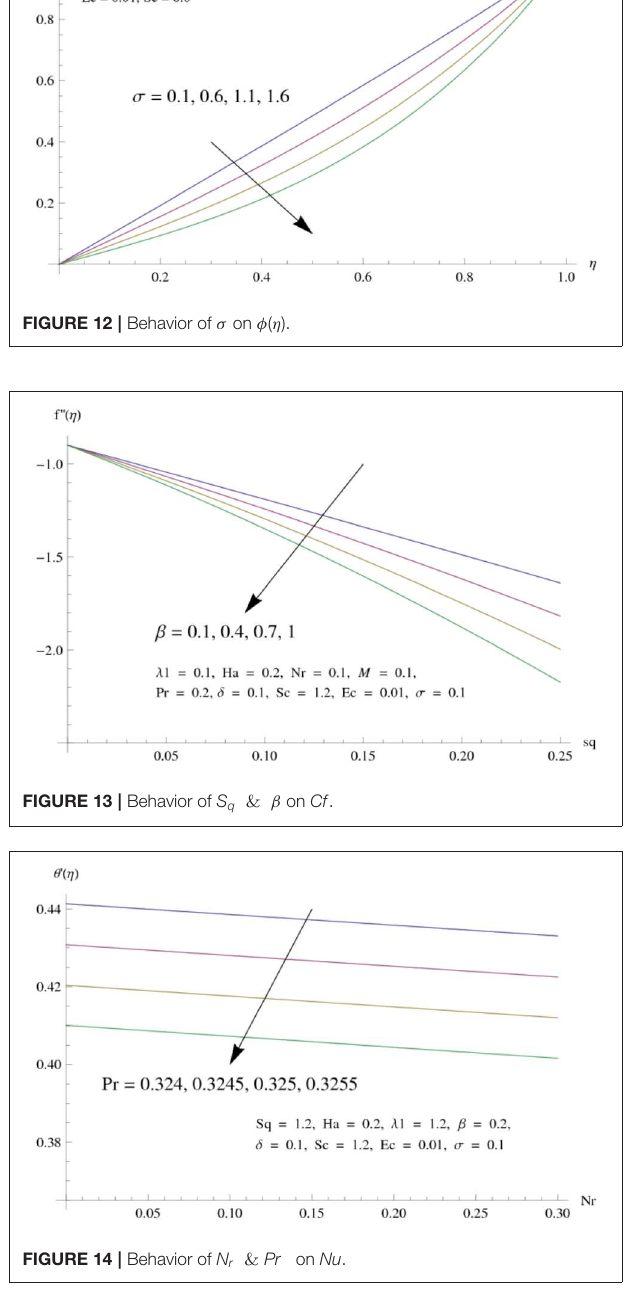
increments in the melting parameter. A physically enlarged melting parameter is responsible for a more convective flow in the transaction of fluid, which is heated toward the cold plate surface, and as a consequence, horizontal velocity component increases. Analysis of the temperature field against the squeezing parameter is depicted in Figure 7 . Here, the temperature field becomes dominant for greater values of the squeezing parameter.